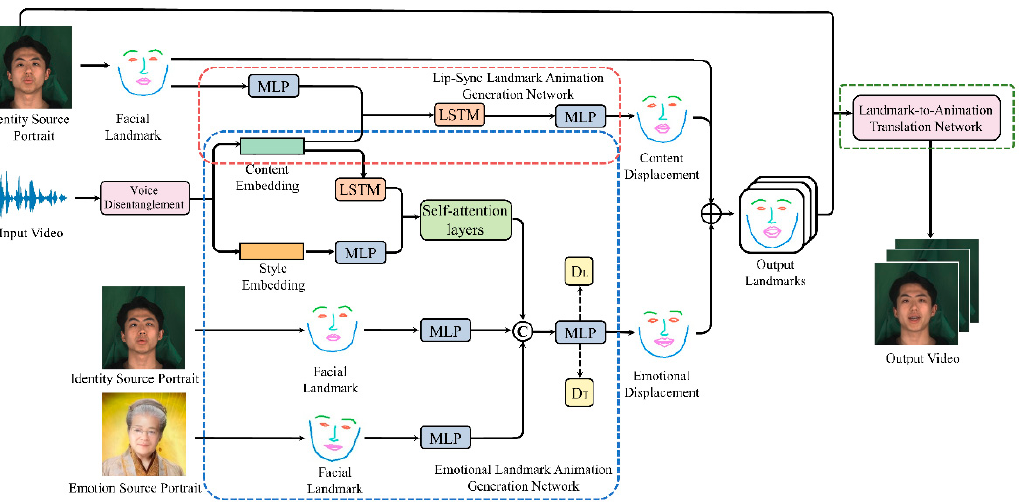
Figure 2. The general framework of the proposed method consists of three network models in dashed lines in three colors. Using the above network structures, the identity source portrait image, emotion source portrait image, and audio are used as inputs to generate an emotionally controllable talking face.